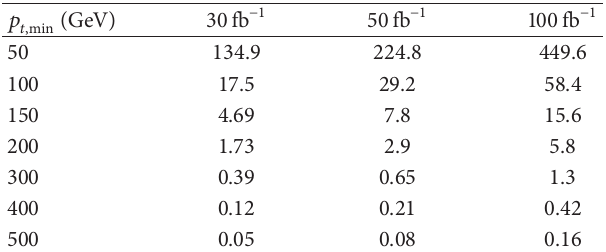
Table2:TheSMeventnumbersof 𝑝𝑝 → 𝑝𝑞𝑞𝑝 processfordifferent values of 𝑝 𝑡 transverse momentum cuts (𝑝 𝑡, min ) and luminosities. Here, acceptance region is taken to be 0.0015 < 𝜉 < 0.5 .